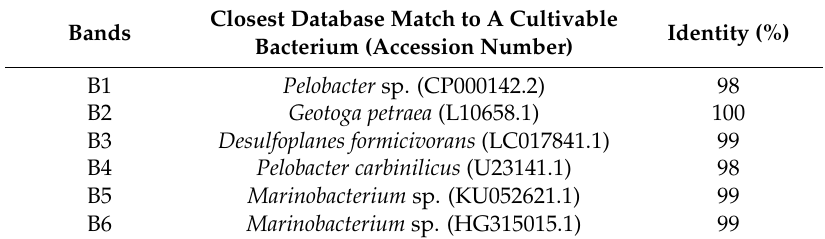
Figure 1. Denaturing gradient gel electrophoresis (DGGE) fingerprints to compare the bacterial communities of the four produced water samples received from Petrobras Ilha Grande Bay Oil Terminal (TEBIG). The letters A and b followed by a number correspond to the water samples and to the band retrieved from the gel that was subsequently reamplified and sequenced, respectively. The letter M indicates the bacterial standard marker. Table 1. Identification (using the Basic Local Alignment Search Tool—BLAST-N) of partial rrs gene sequences of the different bands extracted from the DGGE gel. Bands Closest Database Match to A Cultivable Bacterium (Accession Number)